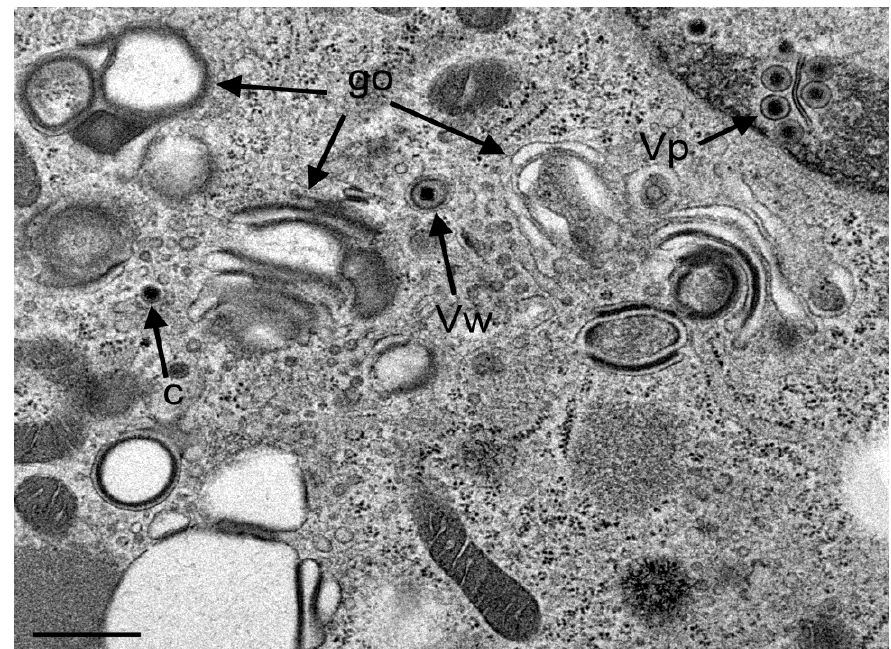
Figure 8. TEM images of R7041(∆U S 3) infected Vero cells at 12 hpi showing three Golgi fields (go) with thick electron dense membranes, and a concentric vacuole enclosing a virion that resulted from wrapping (Vw). There are virions (Vp) in the PNS, and one capsid (c) in the cytoplasm. Bar = 500